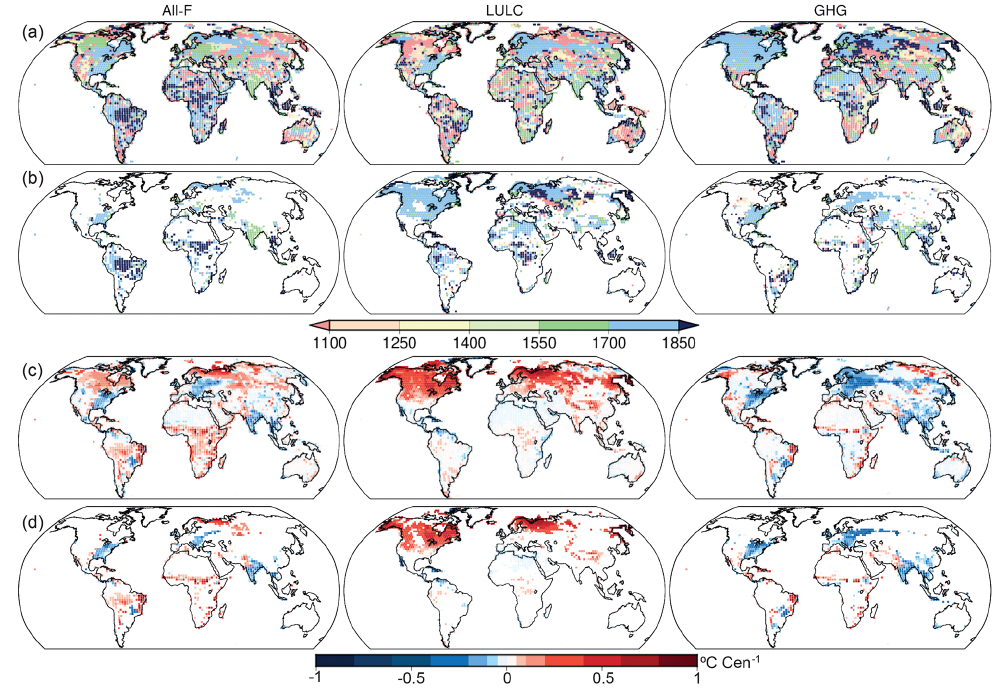
Figure 9. Spatial distribution of the two-phase regression results for SAT minus GST in the ALL- F 2 , LULC 1 and GHG 1 ensembles as examples: (a) dates (years) of change; and (c) trends after the year of change. (b) and (d) are the same as (a) and (c) but only for areas where at least 80% of the ensemble members show significant changes. Trends before the year of change (not shown) are not significant in any of the ensembles. Significance ( p < 0 . 05) is obtained based on an F test ( t test) for year of change (trends) following Solow (1987). Significance also accounts for autocorrelation (Trenberth, 1984). Note that the spatial window has been modified to enhance visualization of land